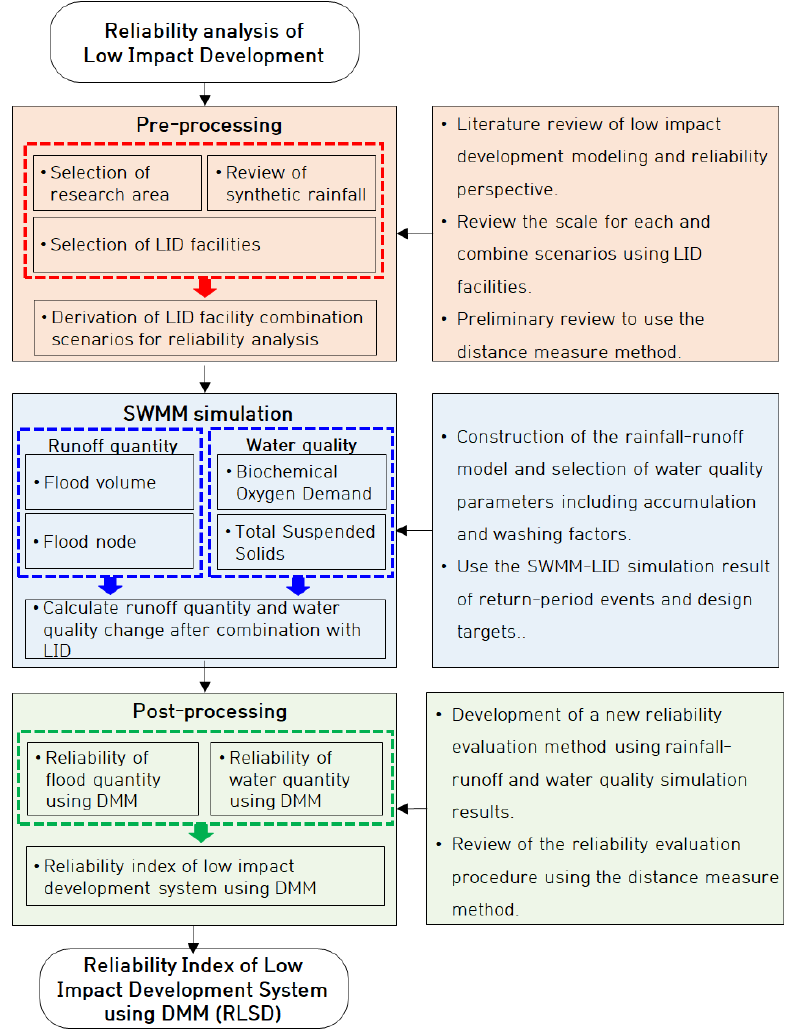
Figure 1. Research flowchart for runoff quantity and water quality reliability analysis of the low impact development (LID) system.